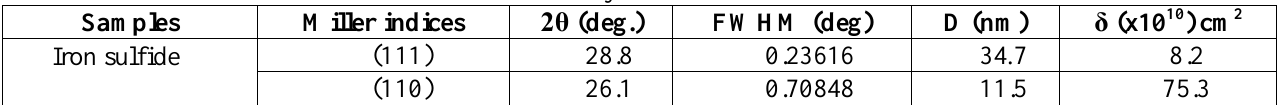
Table 1 : Miller's indices, crystallite size, the position of diffraction peaks (2 ɵ ), FWHM, density of defects,